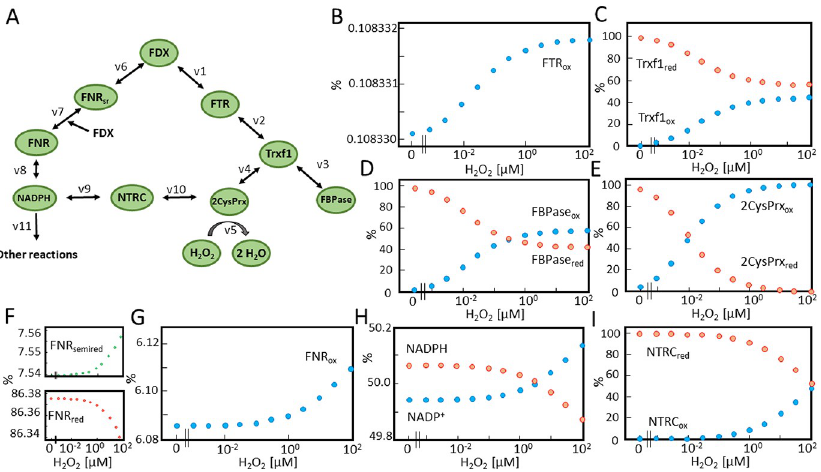
Fig 5. Simulation in the combined model of the redox states of the chloroplast FTR/FNR-network components in the presence of varying H 2 O 2 concentrations. (A) Schematic representation of the combined FTR/FNR-network model. Electrons from FDX could flow either through the FNR branch to NADP + and NTRC or were transported through the FTR branch to TRX-f1 and FBPase. Thus electrons were transferred to 2CysPRX and H 2 O 2 by NTRC and TRX-f1. Each component adopted either a reduced or oxidized state. FNR is represented in three states in the model, the reduced (red), semi reduced (semired) and oxidized (ox) form. The physiological concentrations are calculated for 1 mg chlorophyll (S3 Table). FDX was clamped to 50% reduced state. Estimated start values of FNR red and FNR semired were each set to 40%. The oxidized form was initially set to 20%. Initial values of NTRC, FTR and TRX-f1 were 80% reduced and 20% oxidized. The initial 2CysPRX values were set to 35% reduced and 65% oxidized form [12]. The NADPH/NADP + couple started from a fully reduced state at t = 0. To mimic metabolic NADPH oxidation, the reaction constant v11 was added. (B-E) The redox states of the network components (B) FTR ox , (C) TRX-f1, (D) FBPase, (E) 2CysPRX, (F,G) FNR, (H) NADPH, NADP + and (I) NTRC were simulated for 3h at constant H 2 O 2 concentrations ranging from 0 μ M to 100 μ